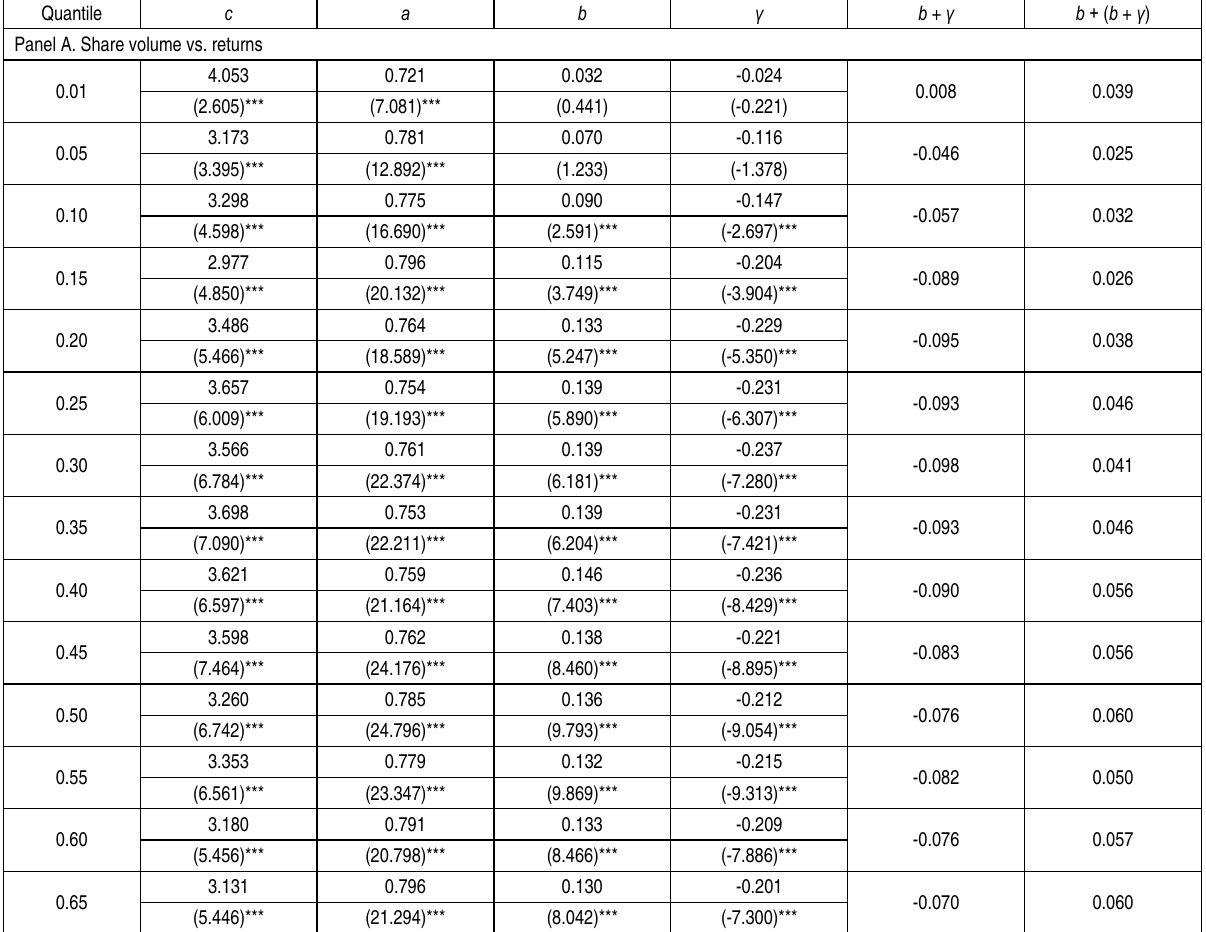
Table 8. Quantile regression estimates of volume-signed return correlation for TAIEX in the entirely-eliminated